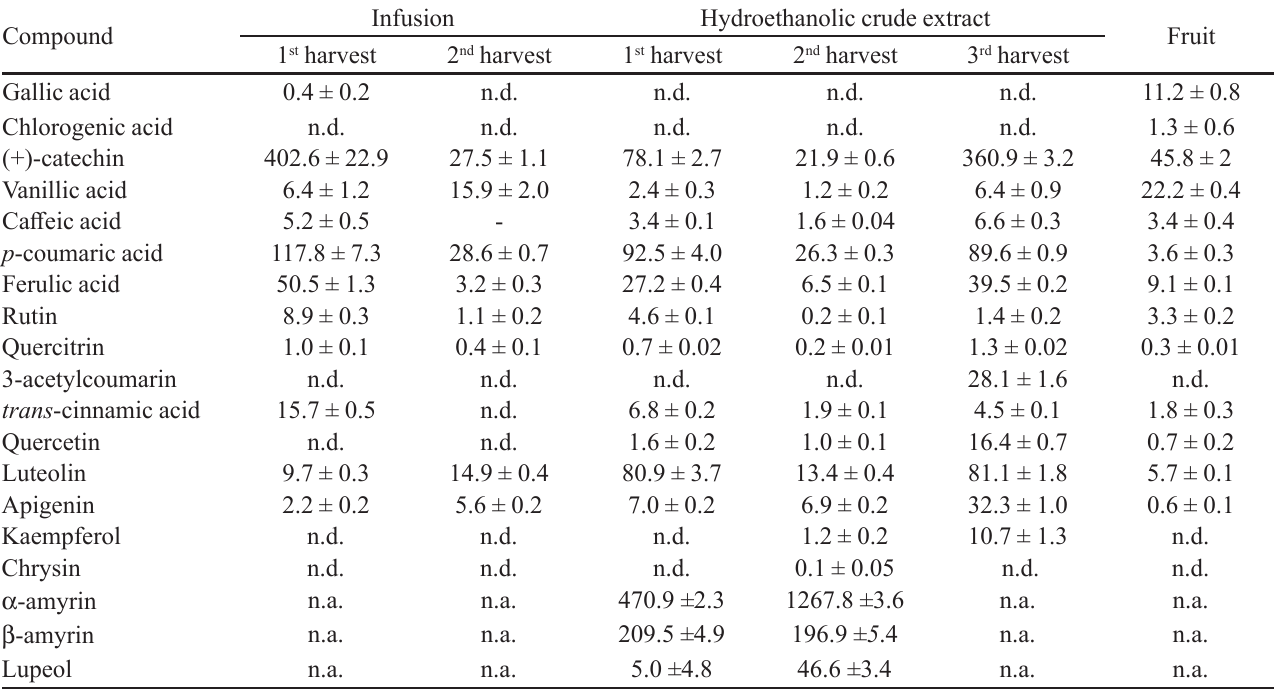
TABLE III - Concentrations of phenolic and triterpenic compounds in Jatropha gossypiifolia L. extracts determined by UHPLC-MS/ MS. Values are given in μg.g -1 of plant followed by standard deviation of concentration